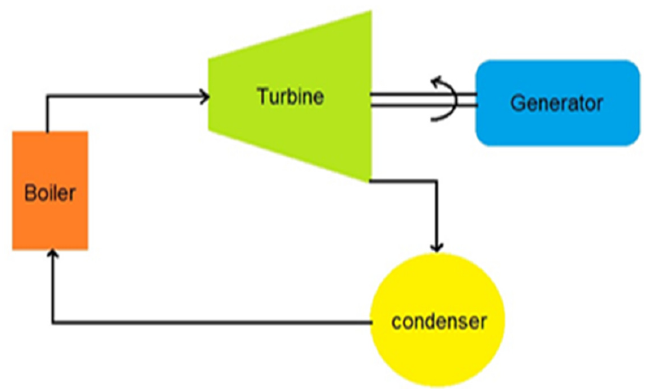
Fig. 2. Parts of Unit